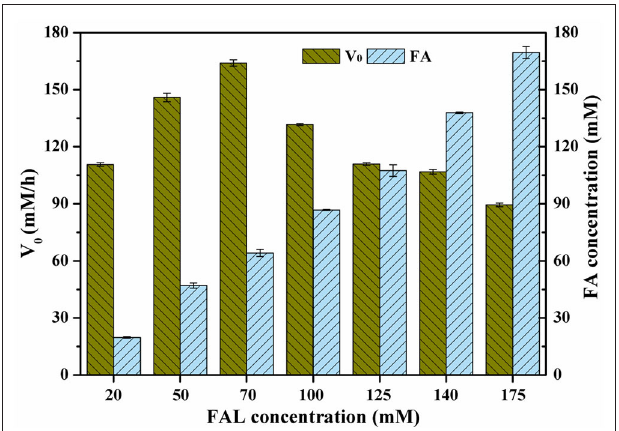
FIGURE 4 | Profiles of selective oxidation of FAL to FA in fed-batch